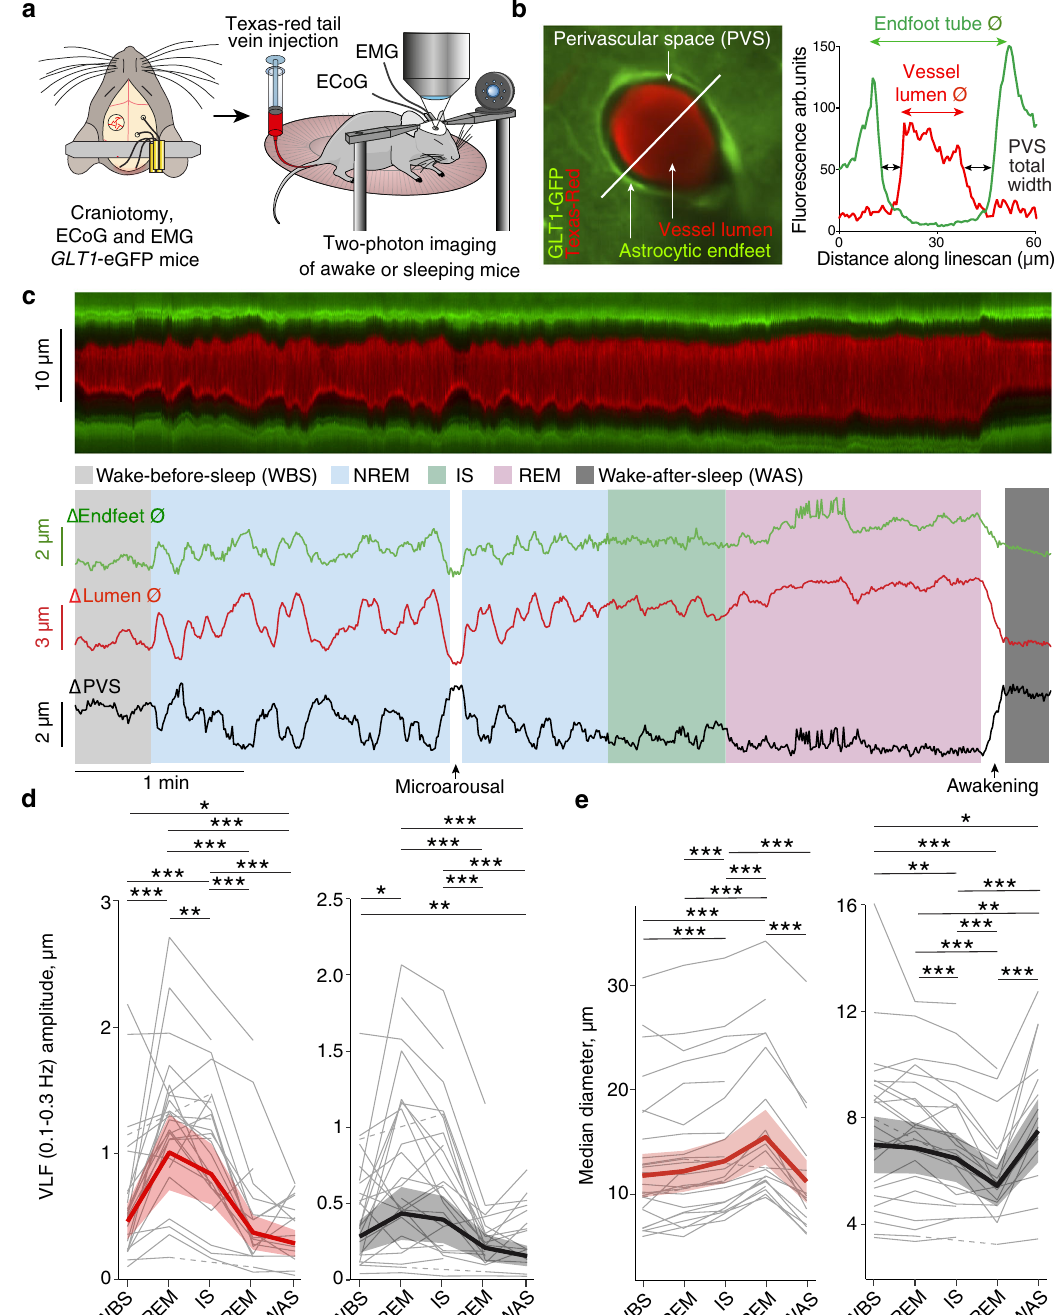
Fig. 2 | NREM, IS and REM sleep states are associated with speci fi c penetrating arteriole diameter changes that are mirrored in the size of the PVS. a Experimentalsetup. GLT1 -eGFPtransgenicmicewere fi ttedwithacranialwindow exposing the somatosensory cortex, ECoG electrodes and EMG electrodes. The vasculature was outlined with Texas Red-labeled dextran. b ( Left ) Representative image of a penetrating arteriolewith GLT1 -eGFP fl uorescencein astrocyticendfeet and Texas-Red labeled dextran in the vessel lumen. Imaging was performed by placing cross sectional x-t line scans. ( Right ) Vessel lumen diameter (Ø) and astrocyteendfoottubediameter(Ø)wasdeterminedalongalineacrossthevessel. Total width of the PVS was assessed as the difference between the vessel lumen diameter and the endfoot tube diameter. c Representative traces of a penetrating arteriolelinescan,changeinendfoottubediameter(Ø),vessellumendiameter(Ø) and perivascular space diameter during a sleep cycle. d Amplitude of very low